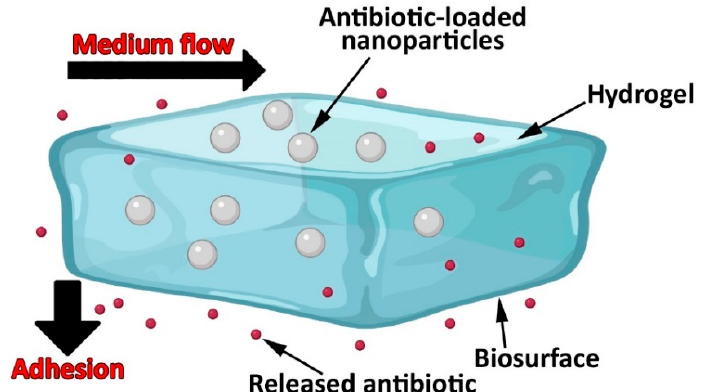
Figure 3. Localized antibiotic delivery using an adhesive nanoparticle-hydrogel hybrid system to prevent the growth of bacteria under flow conditions. In this platform, dopamine methacrylamide, comprising a functional catechol group, is used as an adhesive moiety.